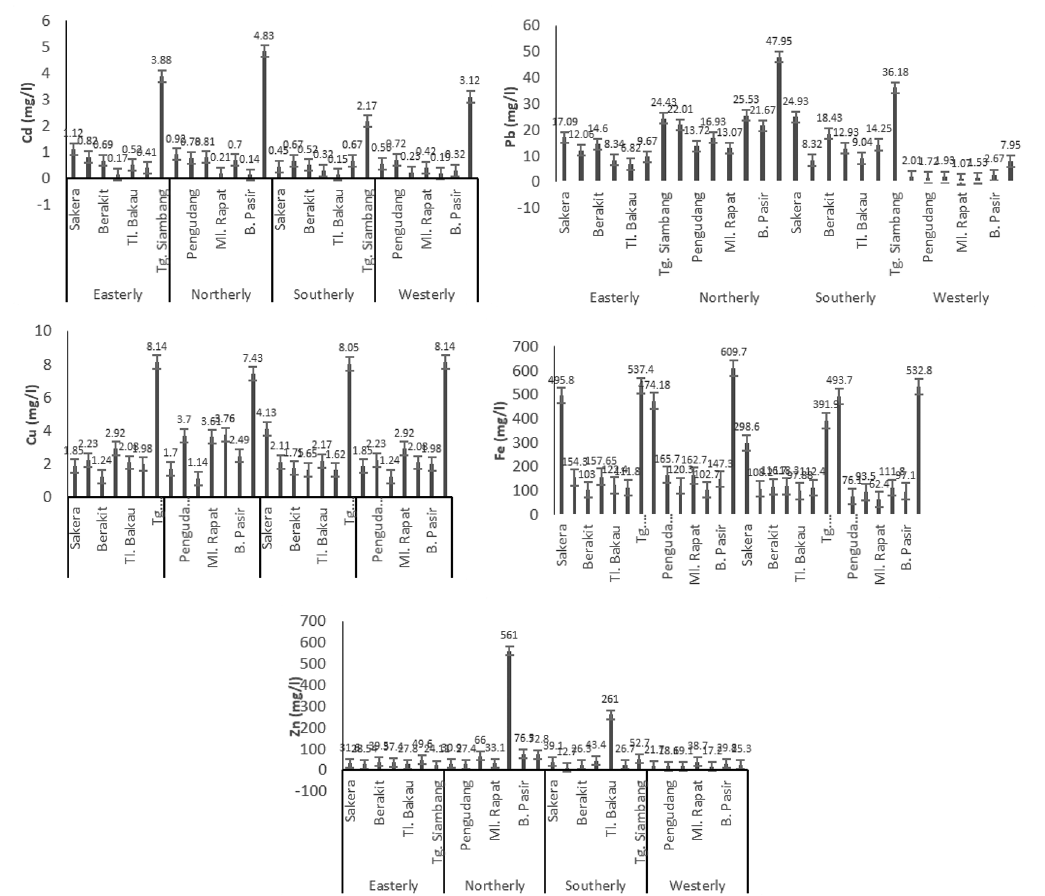
Figure 3. Average concentration of heavy metal (µg/g) of Cd, Pb, Cu, Fe, and Zn in the Caulerva racemosa during Northerly – Westerly monsoon in Bintan Island coastal